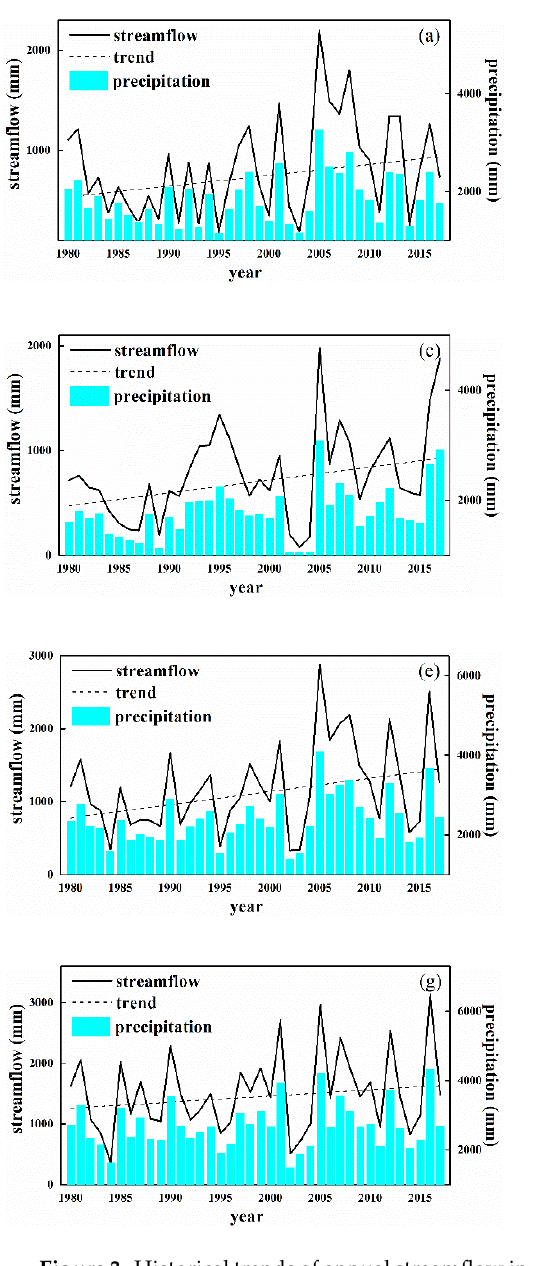
Figure 3. Historical trends of annual streamflow in each river basin from 1980 to 2017. ( a ) Bazhang River Basin, ( b ) Zengwen River Basin, ( c ) Yanshui River Basin, ( d ) Erren River Basin, ( e ) Gaoping River Basin, ( f ) Donggang River Basin, ( g ) Linbain River Basin.